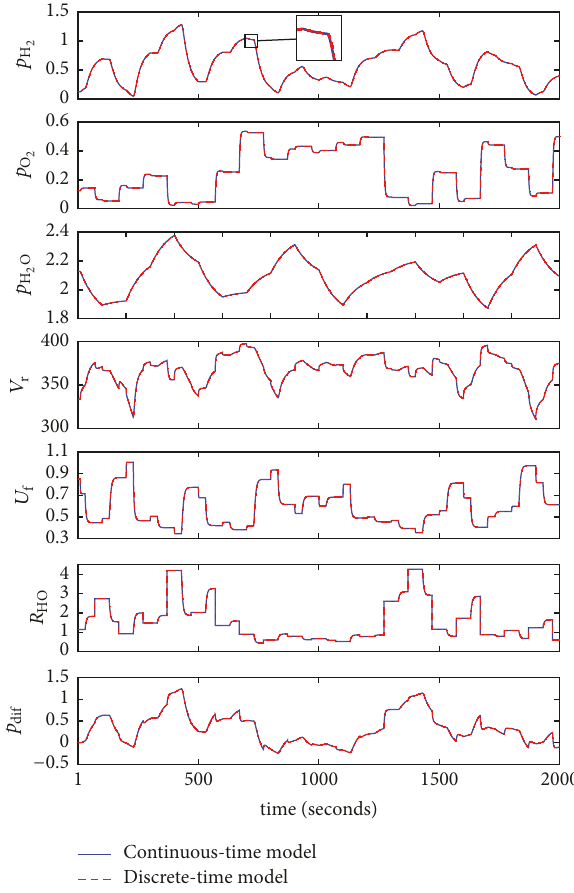
Figure 3: The comparison of the pressures and the outputs calcu- lated from continuous-time and discrete-time models of full